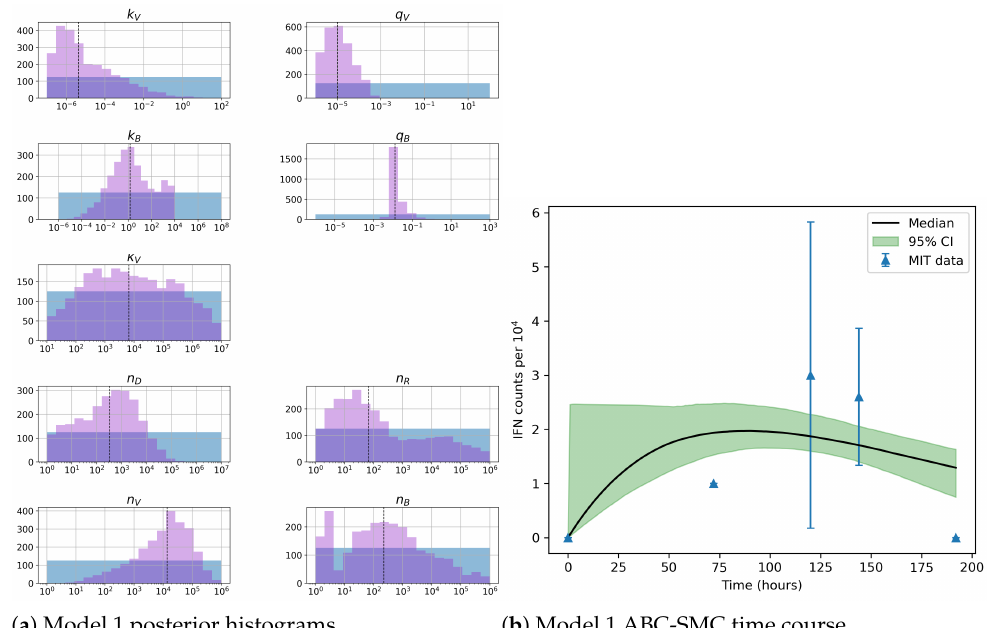
Figure 7. ( a ) Posterior histograms obtained from the ABC-SMC algorithm. Blue histograms indicate prior distributions and purple histograms illustrate posterior ones. ( b ) Model fit from accepted parameter sets obtained during the final iteration of the ABC-SMC algorithm. Blue triangles represent data presented in Table 1 plotted with its standard deviation. The black line illustrates the point-wise median value from the accepted parameter sets (shaded in green) with a 95% credible interval. These results represent 18 iterations with 2500 accepted parameter sets for model 1.